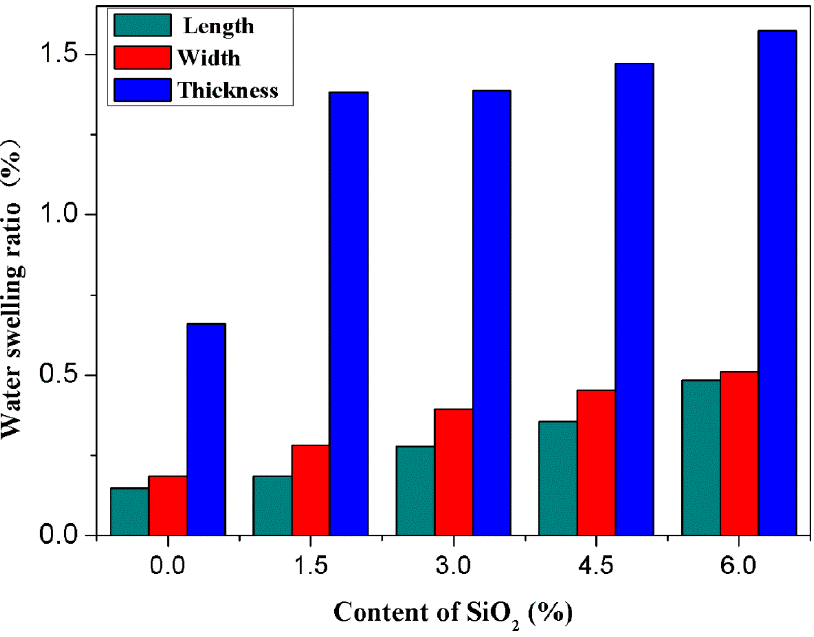
Figure 5. Water swelling ratio of the RHNS/PHBV composites in length, width and thickness directions.